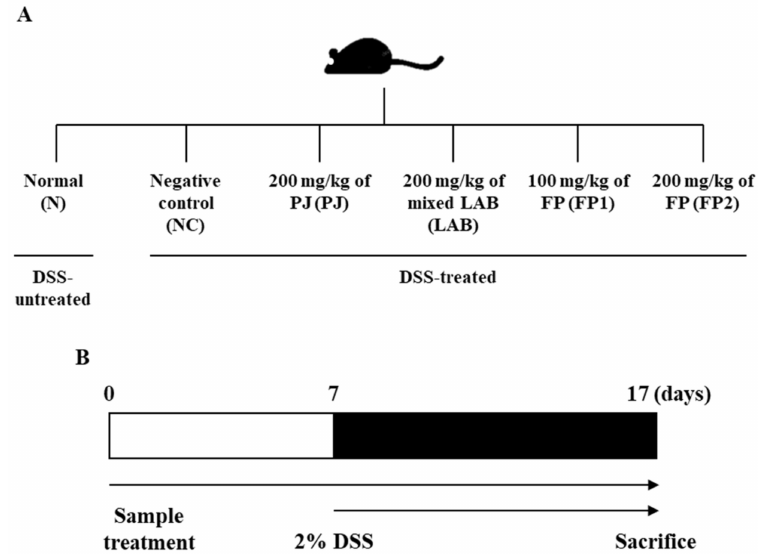
Figure 1. Scheme of the in vivo experimental design. ( A ) Separation of groups ( n = 6) and ( B ) the schedule of dextran sodium sulfate (DSS) and sample treatment. 2% DSS was treated to induce colitis without N group from days 0 to 7, then samples were treated for 10 days from days 7 to 17. Serum and organs were collected on day 17 after